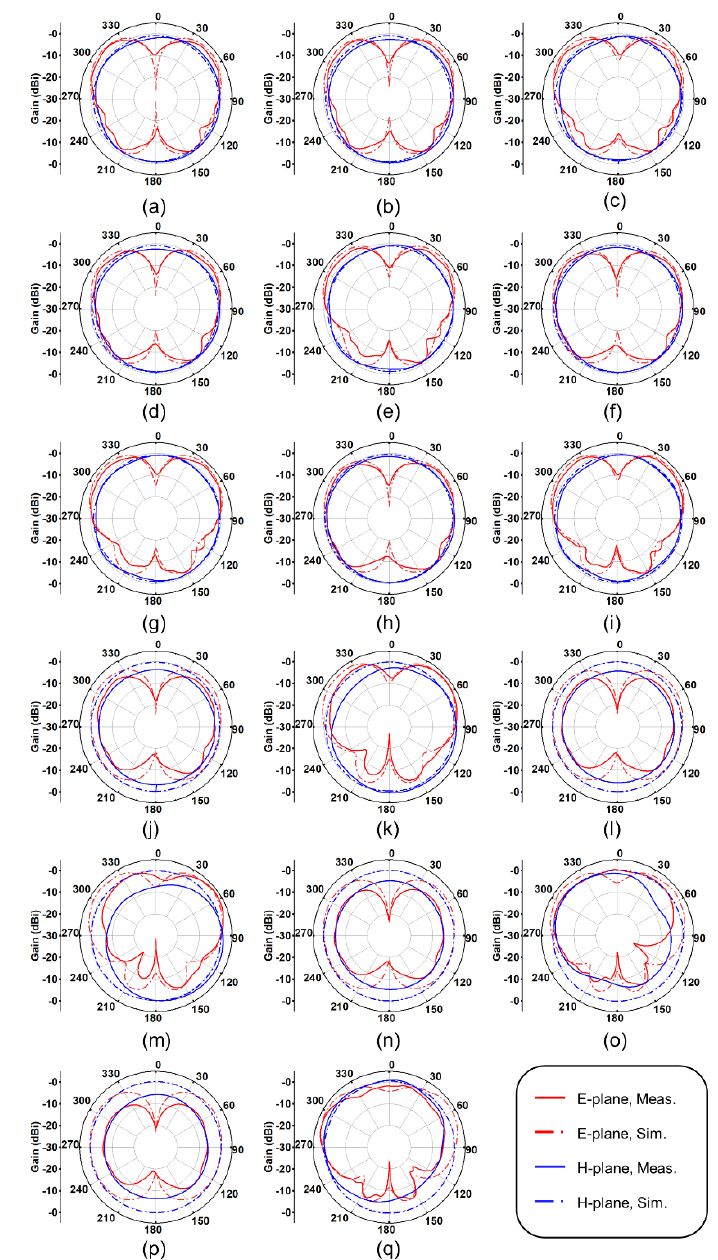
Figure 9. Radiation patterns of E-plane and H-plane (the initial condition: L 1 = L 2 = 12 mm). ( a ) L 1 = L 2 = 12 mm, f L = f H = 2.92 GHz; ( b ) L 1 = 13 mm, f L = 2.84 GHz; ( c ) L 1 = 13 mm, f H = 3.12 GHz; ( d ) L 1 = 14 mm, f L = 2.72 GHz; ( e ) L 1 = 14 mm, f H = 3.32 GHz; ( f ) L 1 = 15 mm, f L = 2.62 GHz; ( g ) L 1 = 15 mm, f H = 3.54 GHz; ( h ) L 1 = 16 mm, f L = 2.52 GHz; ( i ) L 1 = 16 mm, f H = 3.78 GHz; ( j ) L 1 = 17 mm, f L = 2.42 GHz;